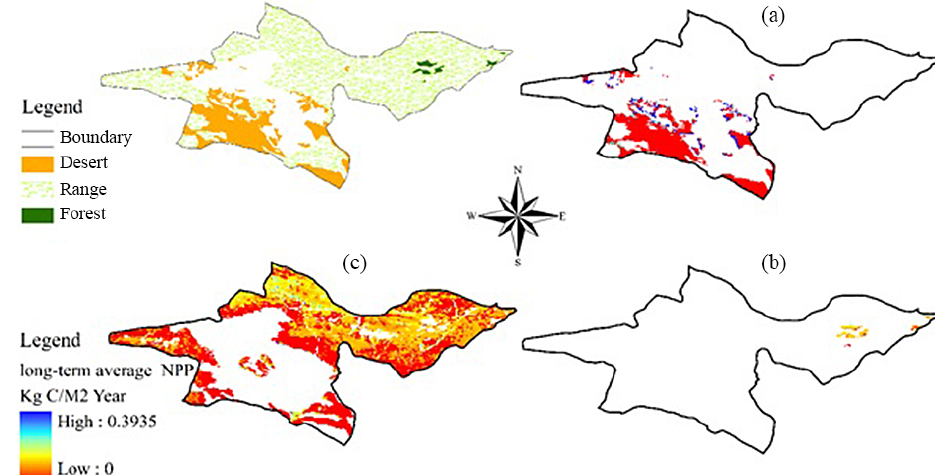
Figure 7. The long-term average of NPP in deserts (a) , forests (b) and ranges (c) .